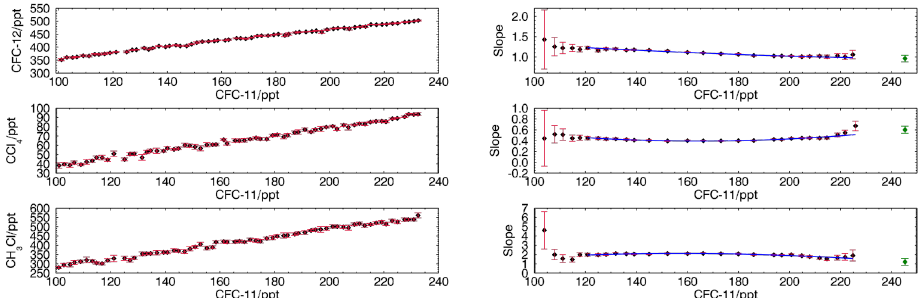
Fig. B6. Correlations between the volume mixing ratios of CFC-12, CCl 4 and CH 3 Cl and CFC-11 for the data from the Northern Hemisphere stratospheric winter of 2005. Left panels: The mean correlation profile. Each point represents the mean of the VMR in a window of 2 ppt of CFC-11. The error on these points is the standard deviation of the data within each 2 ppt window. Right panels: The local slope of data in an 80 ppt of CFC-11 window. The error on the points is the fitting error of this fit. The blue line is a second degree polynomial fit to the local slopes. The green point is the extrapolated slope at the tropopause.